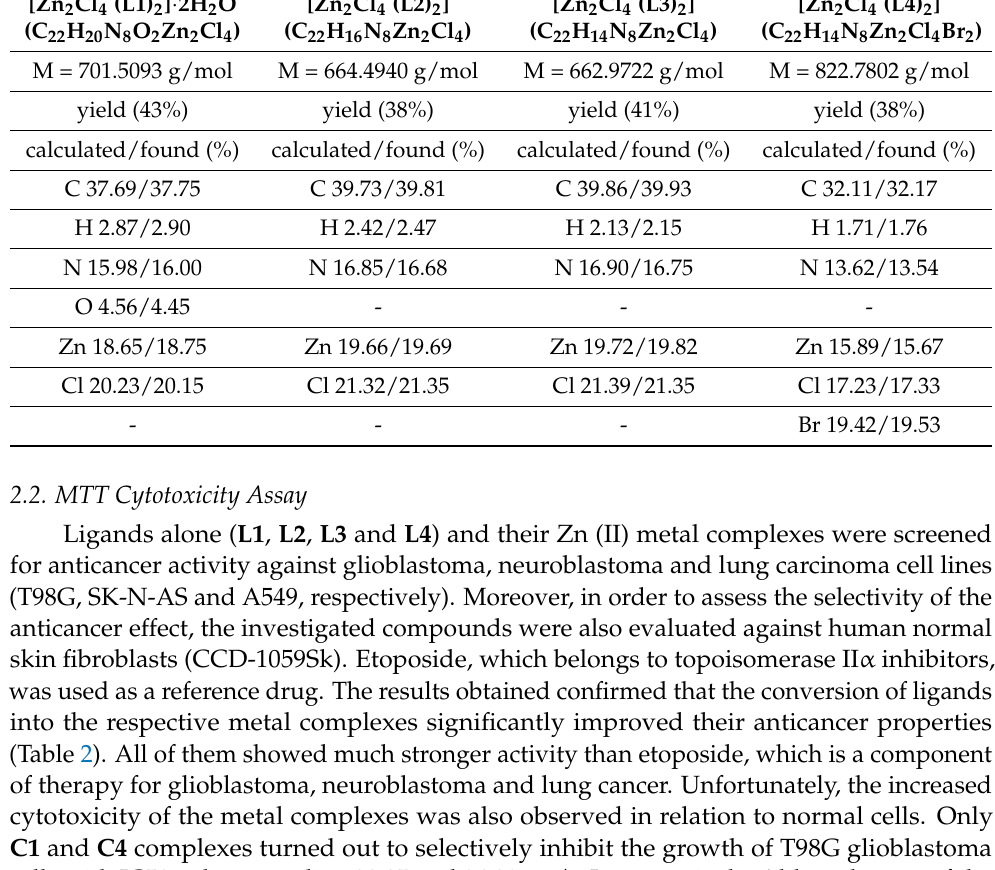
Scheme 3. Synthesis of solid zinc (II) coordination compounds.